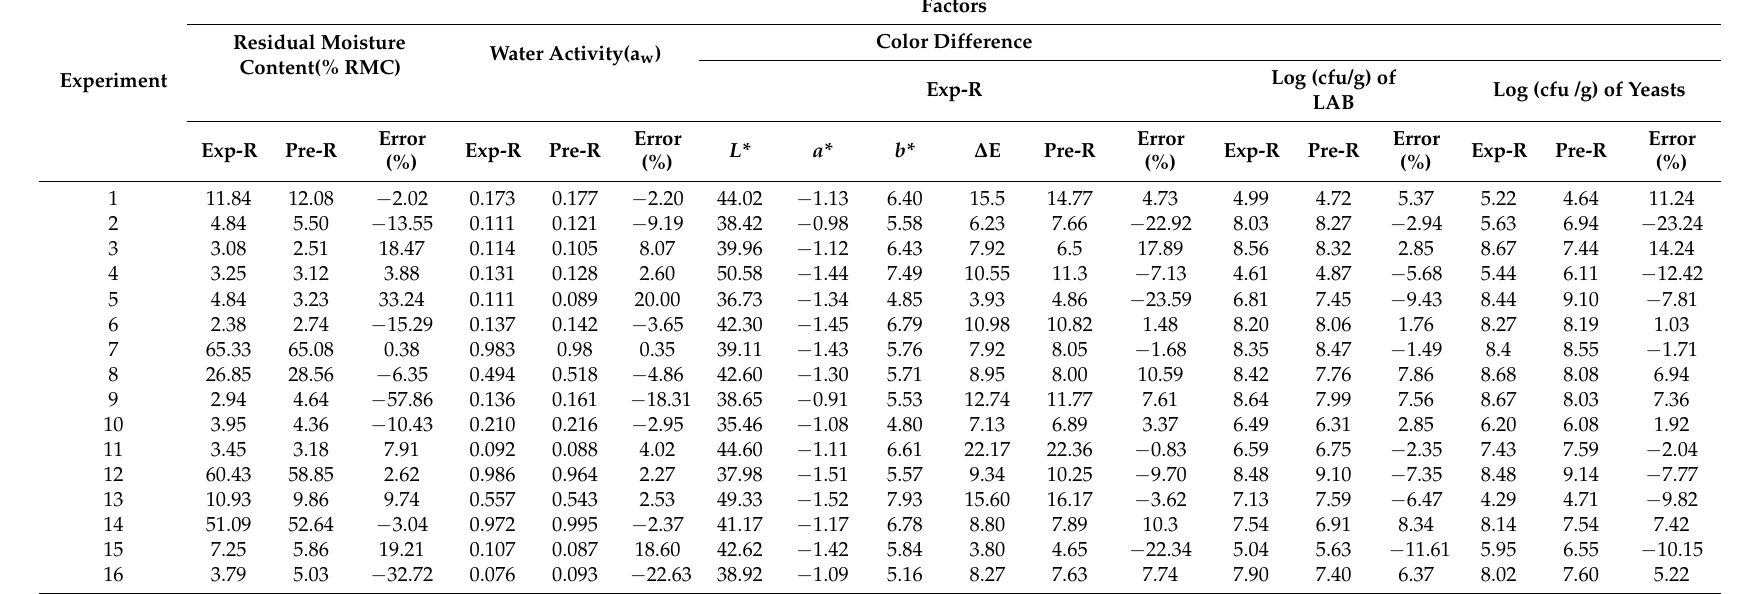
Table 4. Experimental (Exp-R) and predicted results (Pre-R) of dried MKG